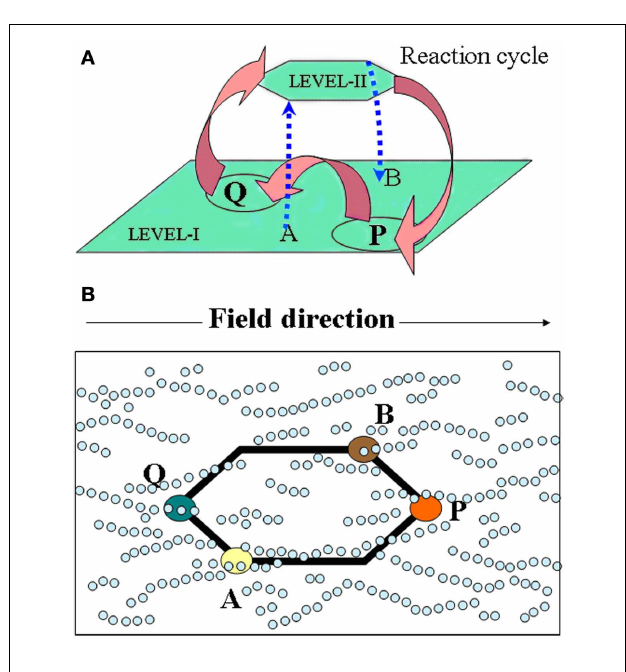
FIGUREA1 |The feedback-coupling between the control-network (level-I) and the metabolic-network (level-II), is extrapolated to the pre-biotic era to rephrase Orgel’s (2000) concerns regarding plausible assumptions on the nature of minimal information-processing capabilities of mineral surfaces for hosting/organizing a proto-metabolic cycle. A capacity for interactions enabling long-range energy and electron transfers (represented by bold orange and dashed blue arrows, respectively) is needed at level-I – the hosting surface, depicted as a green parallelogram, – for proto-metabolic reaction cycles to organize at level-II – depicted as green hexagon. Did the host-surface at level-I have the ability to capture and channel the thermal energy released into it, say at point P (i.e., from an exothermic reaction taking place at level-II), to another spatio/temporal location, say point Q, where potential reactants (for endothermic reaction at level-II) could get recruited into the expanding cycle? Similarly electrons, required for some reactions of the cycle, would have led to exchanges (shown in blue dashed arrows) with the level-I catalytic colloids. (B) The possibility of percolation through an inorganic network of dipolar interactions makes it interesting to consider a field-controlled network of magnetic mineral-particles as a hosting surface to pre-biotic attractor cycles a la level-I. (B) Is a top view of (A) , where the green parallelogram representing the hosting surface is a “layer” of field-structured colloids, adapted from Figure 2 , main text.We speculate that transfers of electrons and heat energy through the dipolar network (see Percolation of Heat, Electrons) could drive the magnetic system out of equilibrium.This is since each individual particle’s composite magnetic moment in turn is directly affected by its redox state, and also the local temperature, thus affecting their collective dynamics.Taken above a threshold these feedback effects have the potential to cause phase-transitions to regimes with new types of collective ordering, leading to a long-range